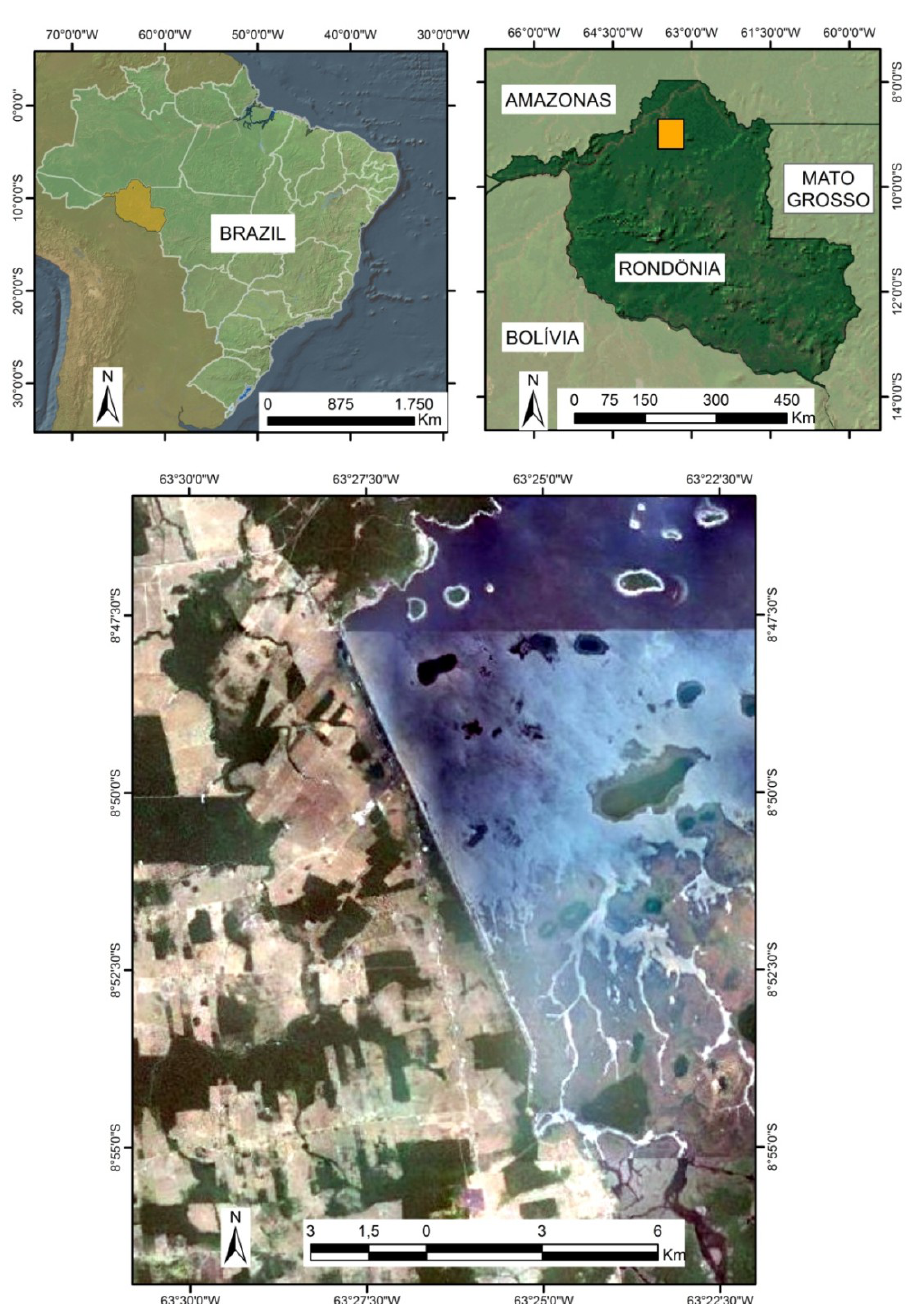
Figure 1. Study location in the municipality of Candeias do Jamari,